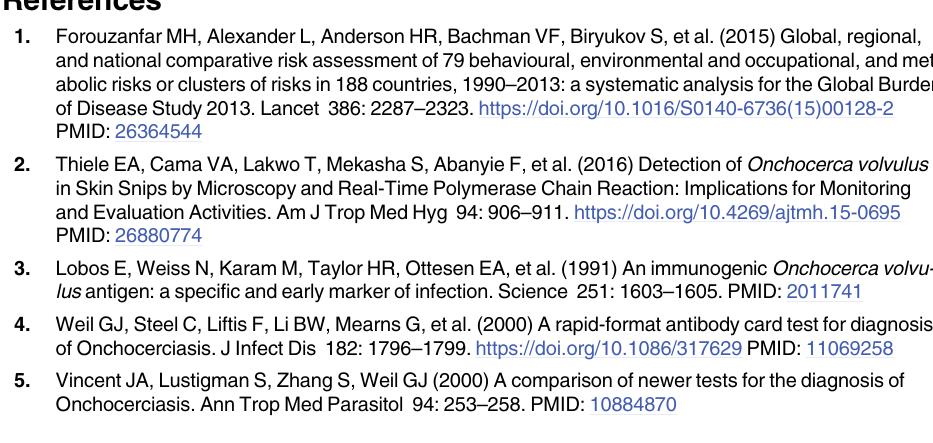
S3 Table. All O . volvulus -derived proteins identified in the serum and urine infected mice. The table lists all the O . volvulus -derived proteins identified exclusively in the infected mice and not in the control mice. The values denote peak area intensity of the peptides identified for each